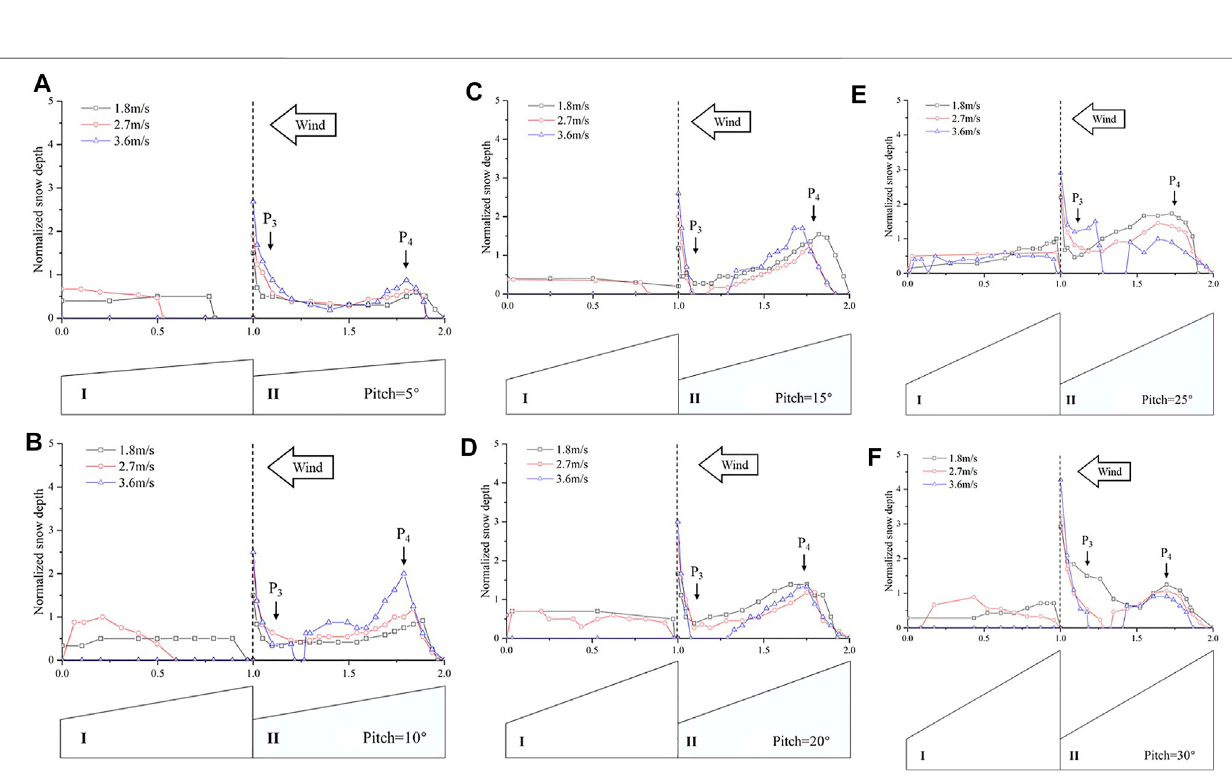
FIGURE 10 | Normalized snow depth along the centerline ofthe roof for the negative wind direction. (A) pitch = 5 ° (B) pitch = 10 ° (C) pitch = 15 ° (D) pitch = 20 ° (E) pitch = 25 ° (F) pitch = 30 ° . Frontiers in Earth Science |